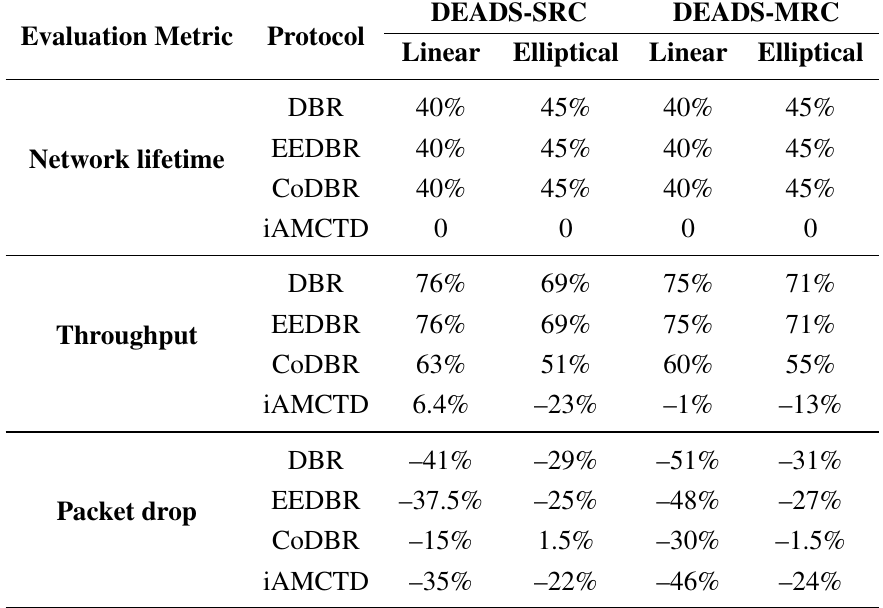
Network lifetime